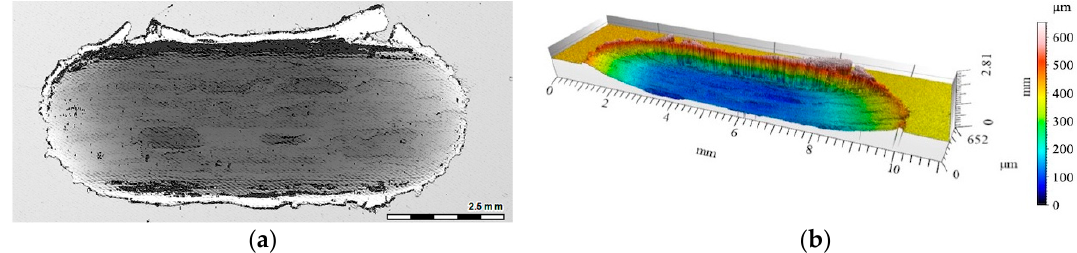
( b ) Figure 9. View of a wear trace in an un-reinforced area (AlSi7 matrix marked with blue line on Figure 8a) after dry sliding condition (Figure 8b): ( a ) Digital image; ( b ) Cross-section using a 3D view. Comparing single composite layers made of suspensions containing different SiC contents (designated S5, S10, and S15) with the un-reinforced matrix, a similar trend was observed in the coefficient of friction (Figure 8a). However, its value decreased as the volume of SiC ceramic particles used in the initial composite suspension increased. The highest value of the coefficient of friction ( μ = 0.4) was achieved for the S5 composite, in which the volume fraction of the reinforcing phase was 5 wt.% (black line in Figure 8a). The higher SiC content lowered the coefficient of friction. For the sample with 10 wt.% SiC particles (S10), the mean value of the coefficient of friction was μ = 0.33 (gray line in Figure 8a). The smallest coefficient of friction value ( μ = 0.25), was registered for the composite with 15 wt.% reinforcing particles (green line in the Figure 8a). As can be seen, at the initial stage of friction (500 m) for the single composite layer marked S15, the coefficient of friction was significantly higher than the value recorded during the second half of the sliding distance. After the break-in period, the value of the friction coefficient during sliding changed from μ = 0.21 to μ = 0.16 at the final stage of friction. In addition, the friction coefficient value stabilized over the course of the test. The differences between the minimum and maximum values of the registered coefficient of friction ranged from 0.1 for composite S5 to 0.06 for composite S15. Based on the obtained results, it can be concluded that for the tested tribological couple, 5 wt.% SiC in the initial composite suspension did not strengthen the composite. This effect was directly related to the pull out phenomenon and the crushing of reinforcement particles during friction tests [4]. An improvement in the tribological properties was observed for 10 wt.% particles. In this case, the greater weight fraction of the ceramic particles limited the impact of the particles removed due to wear. The nature of the friction coefficient change was significantly different for composite layers containing glassy carbon spheres. In both cases, the coefficient of friction was stable, but its value was significantly different (red and purple lines in Figure 8a). For the hybrid-reinforced composite layer marked C3S7, the value of the friction coefficient during sliding distance changed slightly from μ = 0.16 to μ = 0.14. In contrast, composite layer C5 showed a more noticeable change, and reached a value of μ = 0.35 during the final stage of friction. These results clearly indicate that the highest coefficient of friction was recorded for single composite layers S5 ( μ = 0.4) and C 5 ( μ = 0.35). In turn, the use of hybrid reinforcement (SiC